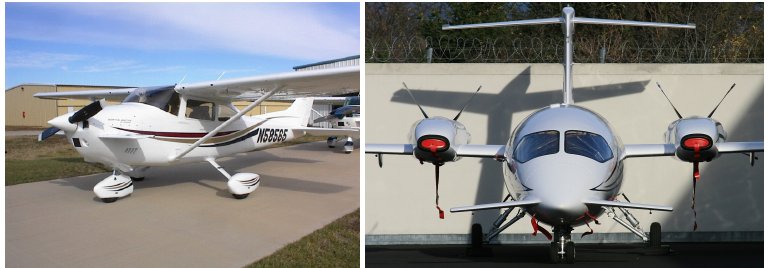
Figure 1. Examples of existing three-surface aircraft. ( Left ): Wren 460 [15]. ( Right ): Piaggio P180 EVO